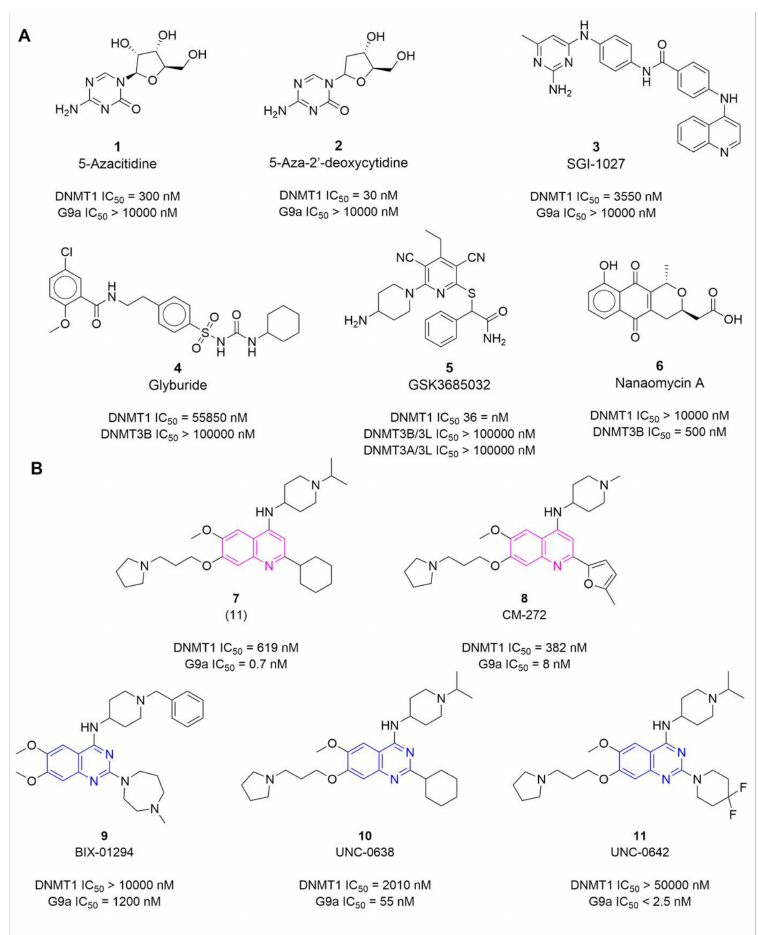
Figure 1. Chemical structures of ( A ) examples of known DNMT inhibitors and compounds with demethylating activity; ( B ) dual DNMT1/G9a inhibitors (quinoline- and quinazoline-based deriva- tives) reported in the literature. The dual activity profile as available in the literature for epigenetic targets is indicated